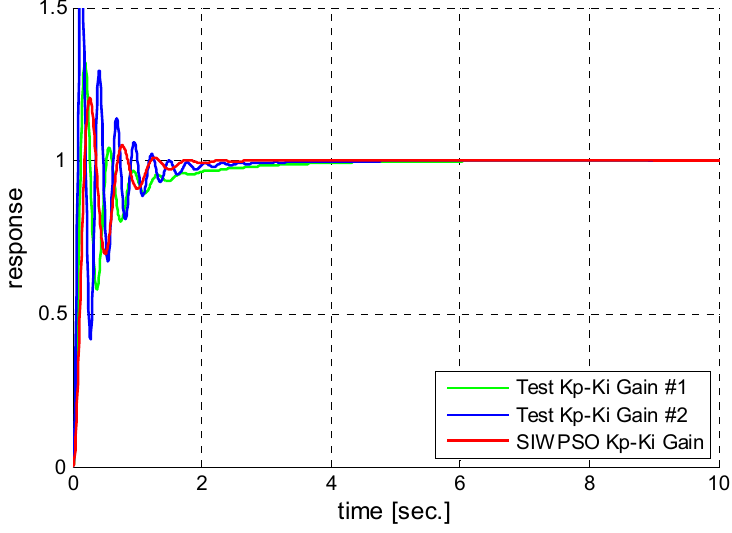
Figure 10. Performance verification of the drive train system.